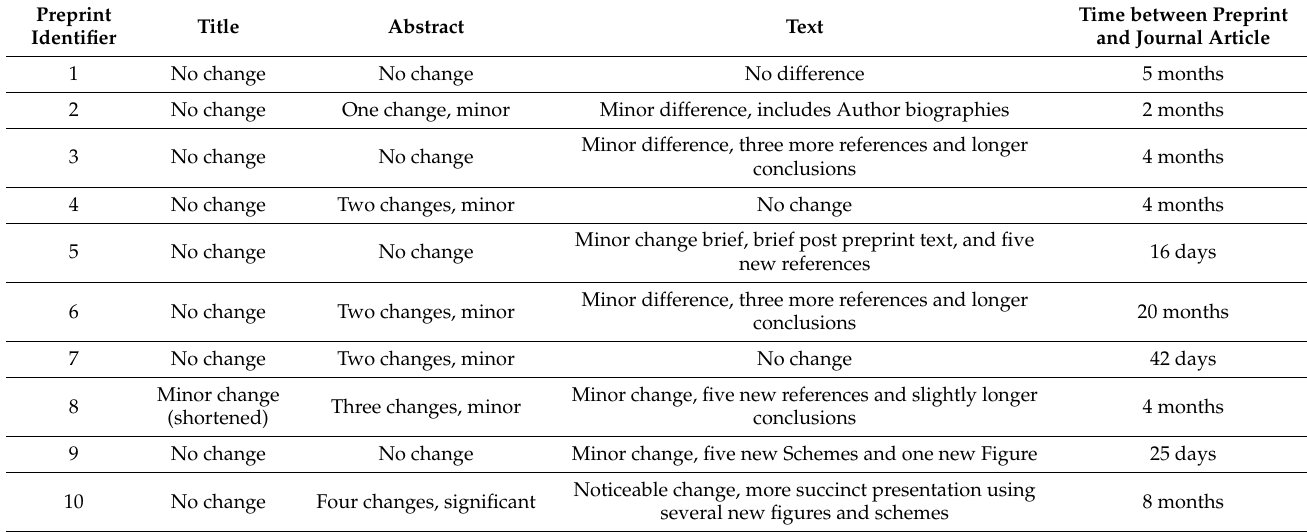
Table 3. Changes across each of the ten selected studies between final published journal article and preprint and time between preprint and journal article